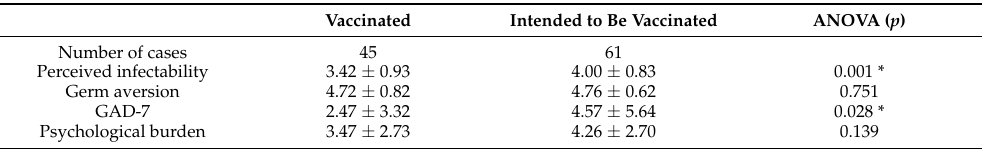
Table 5. Comparison of psychological scores between HCWs who were already vaccinated and those who only expressed an intention to be vaccinated ( T